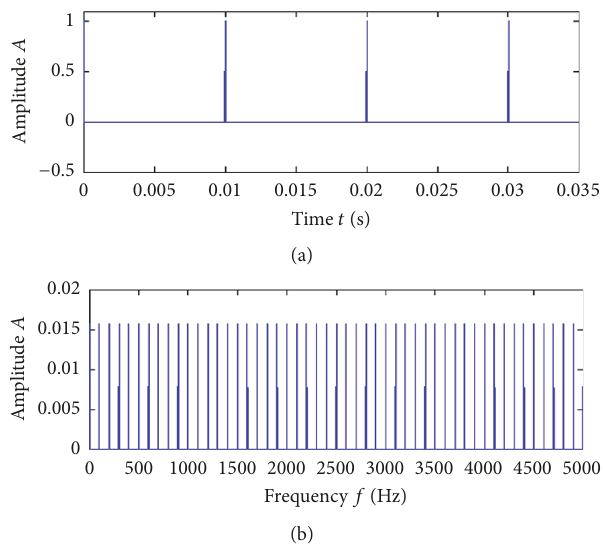
Figure 1: Simulated periodic impulses: (a) time domain waveform and (b) FFT